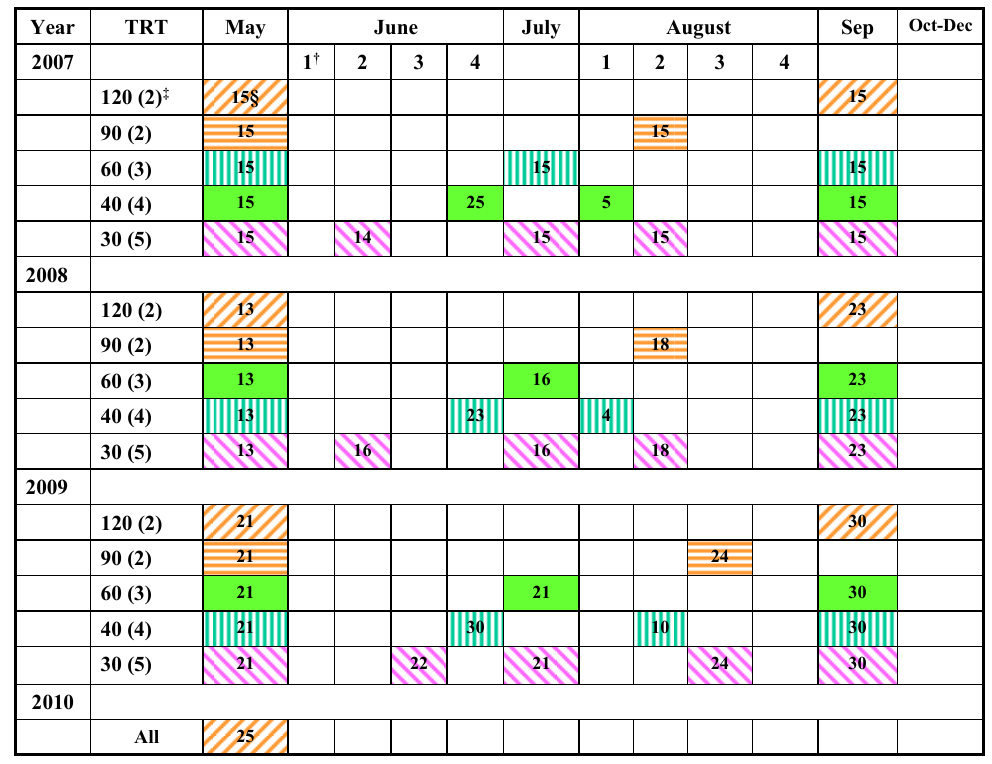
Figure 4. Actual harvest dates by treatment and year. † Weeks in a month. ‡ Days between successive harvests with total harvests per year, including the equalizing May-harvest, in brackets. § Actual harvest date for the indicated treatment (TRT) in the respective